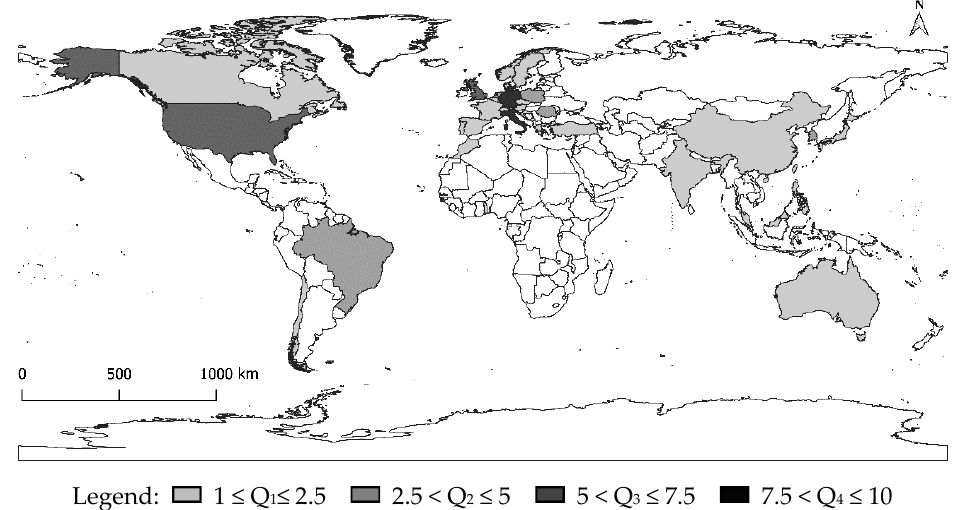
Figure 5. Spatial distribution of countries, by quartiles, from which public policy publications on renewable energies from the perspective of the CE originated.